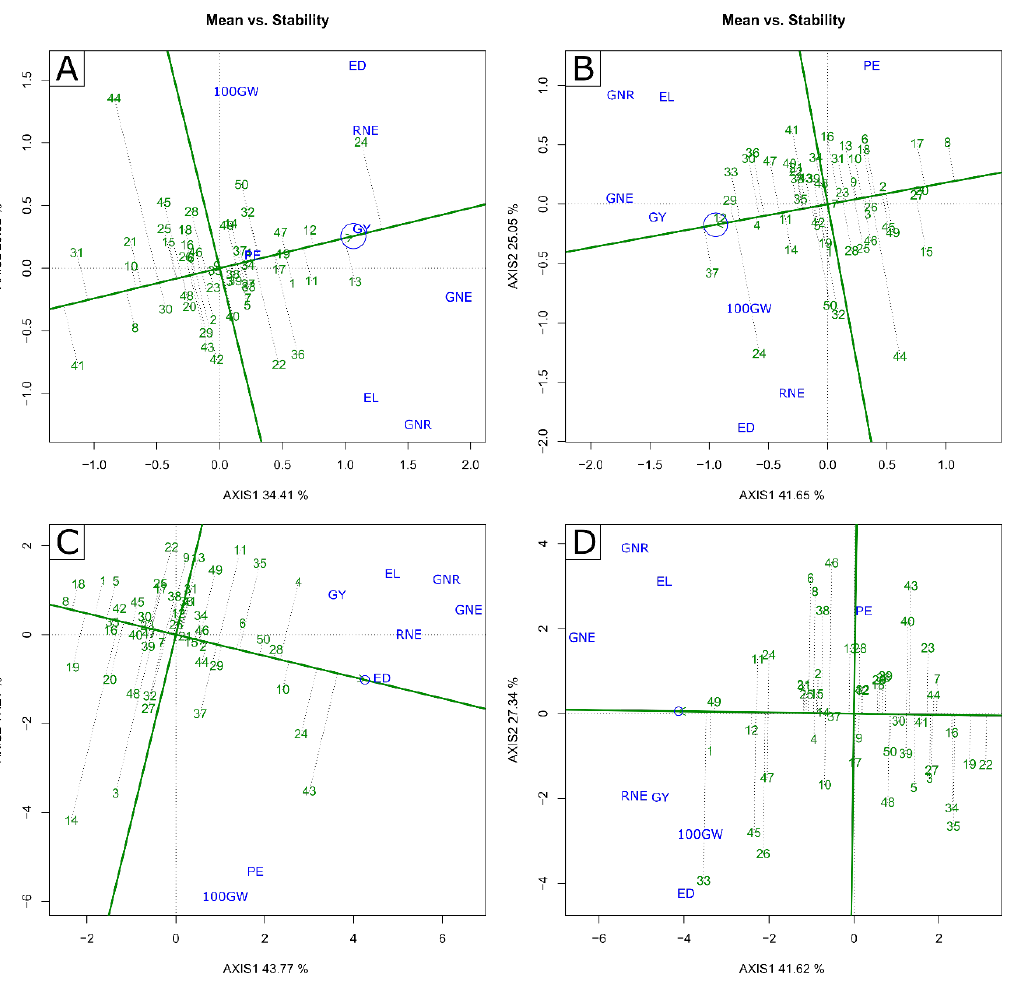
Figure 3. Biplot “Mean vs. Stability” graph for ( A – C ) water stressed (WS) and ( B – D ) well-watered (WW) conditions in crop seasons 2020 ( A , B ) and 2021 ( C , D ). GY — grain yield; PE — Popping expan- sion; GNE — grain number per ear; 100 GW — 100-grain weight; RNE — Row number per ear; GNR — Grain number per row; ED — Ear diameter; EL — Ear length; (-) signal indicating negative values.